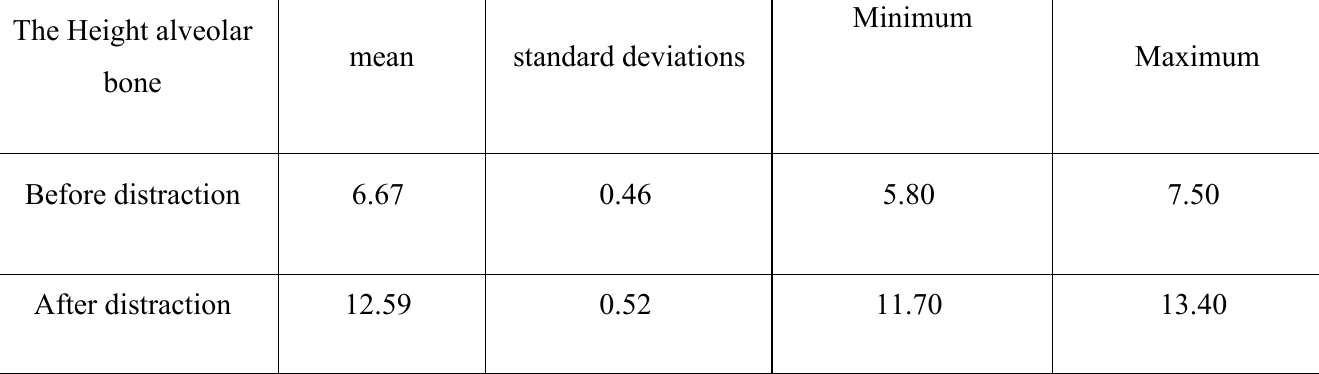
Table 3: Means, standard deviations, and ranges of the heigh alveolar bone in the distraction osteogenesis (DO).